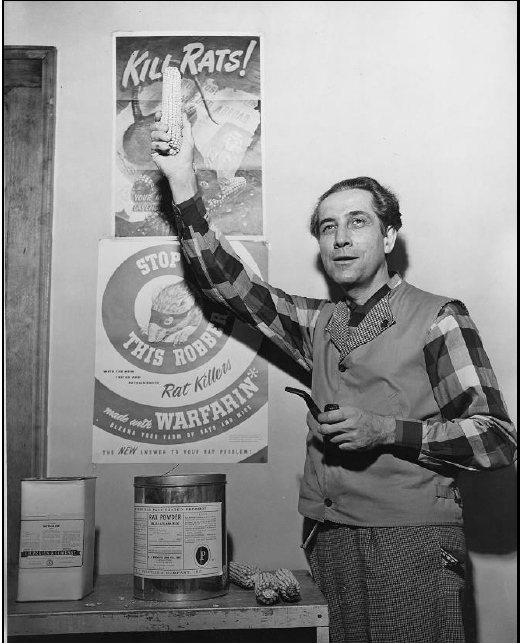
Figure 5. Karl Paul Link, Professor of Agricultural Chemistry at the University of Wisconsin, standing in front of a poster advertising Warfarin, a compound he and fellow researchers patented with the Wisconsin Alumni Research Foundation [81]. Trop. Med. Infect. Dis. 2021 , 6 , x FOR PEER REVIEW